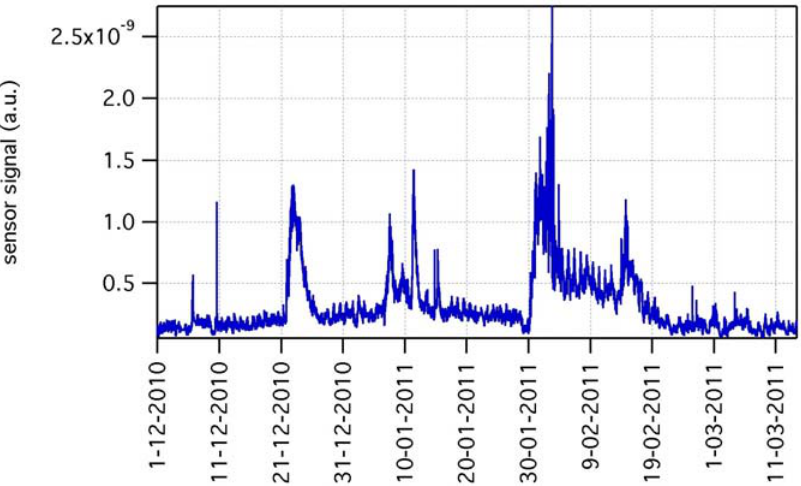
Figure 9. Gas sensing signal during outdoor experiment, in the period December 2010–March 2011.